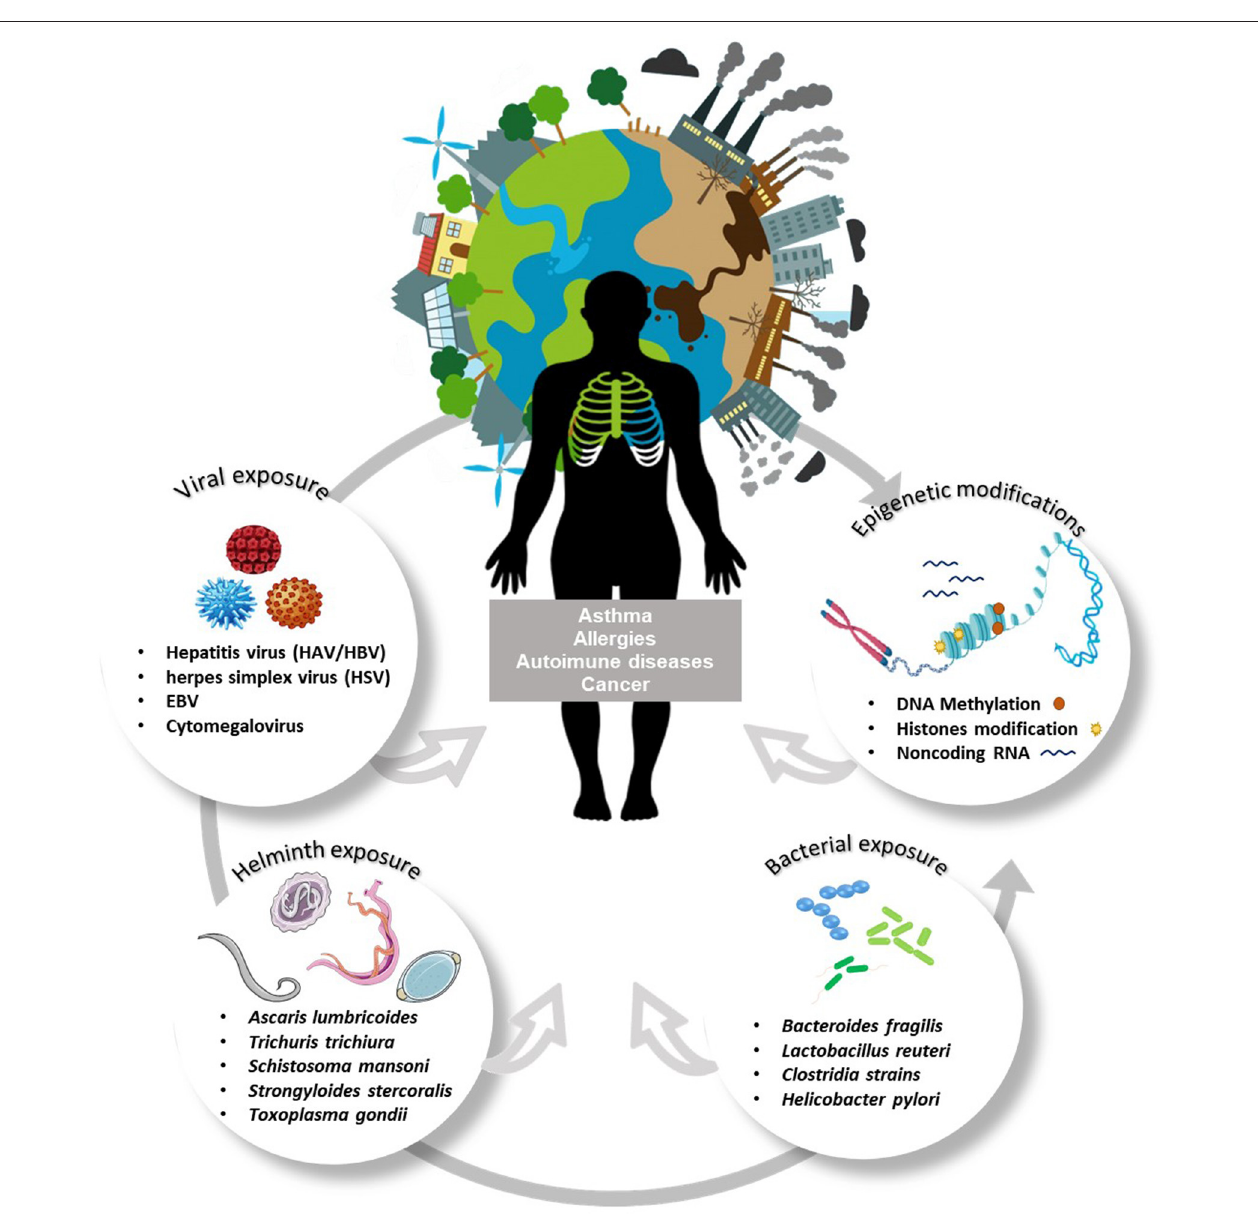
FIGURE 1 | Interaction between multiple environmental exposures and epigenetic changes: impact on immune-mediated diseases. Polluting agents, environmental exposure, diet, age, drugs, and especially exposure to organisms (species of bacteria, fungi, protozoan, and helminths) act as inducers of epigenetic changes. Among the epigenetic modifications are DNA methylation and histone modifications. Histone acetylation increases DNA access and facilitates the process of transcription, increasing gene expression. The addition of a methyl group in CpG islands prevents the binding of transcription factors and represses gene expression. The interaction between environmental exposures and epigenetic variations begins in the embryonic period and continues throughout life, being strongly dependent on the environmental experiences/challenges of everyone. Such alterations can be highly modifiable by instantaneous adaptation to the environment or generate inheritable epigenetic patterns and consequences to offspring. Epigenetic mechanisms influence cell differentiation and polarization of immune responses, these events modulate biological responses, and can interfere with the development of different immune-mediated diseases such as cancer, asthma, allergies, autoimmune